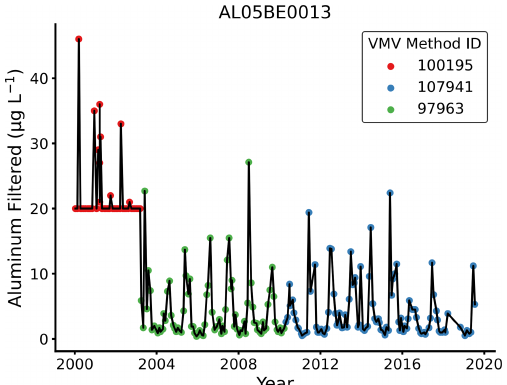
Figure 4. Example of change in analysis methodology on de- tected concentrations. Coloured points represent different analysis methodologies. For non-detected concentrations, the detection limit is